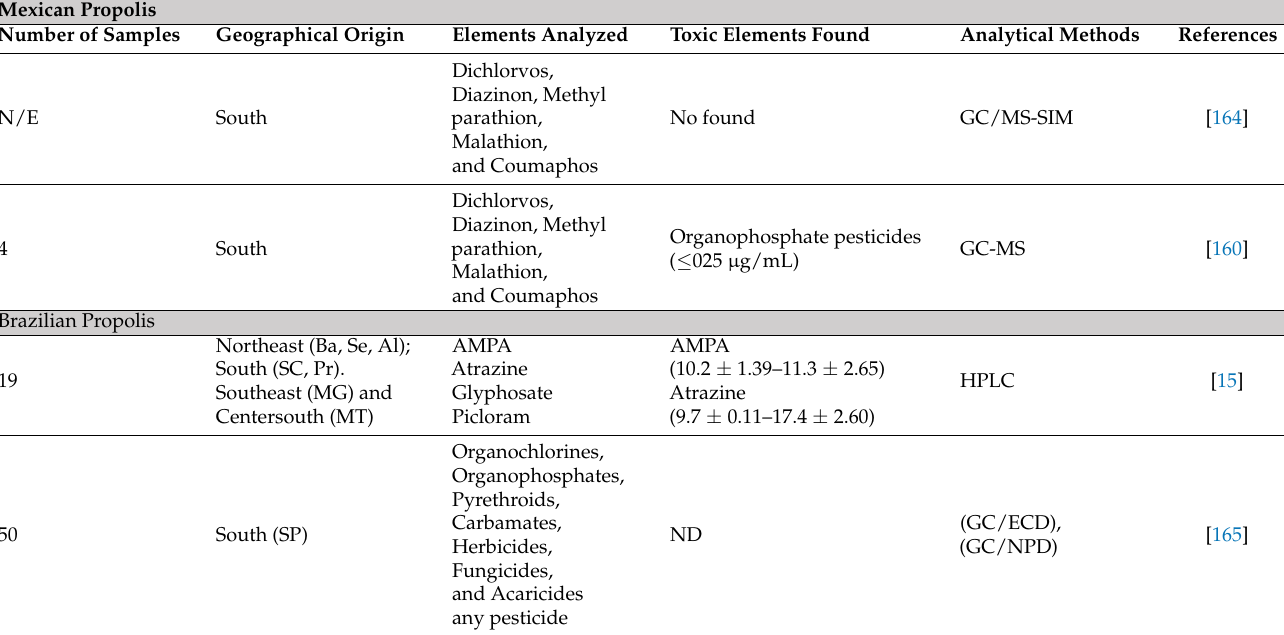
Table 4. Pesticides research in Brazilian and Mexican